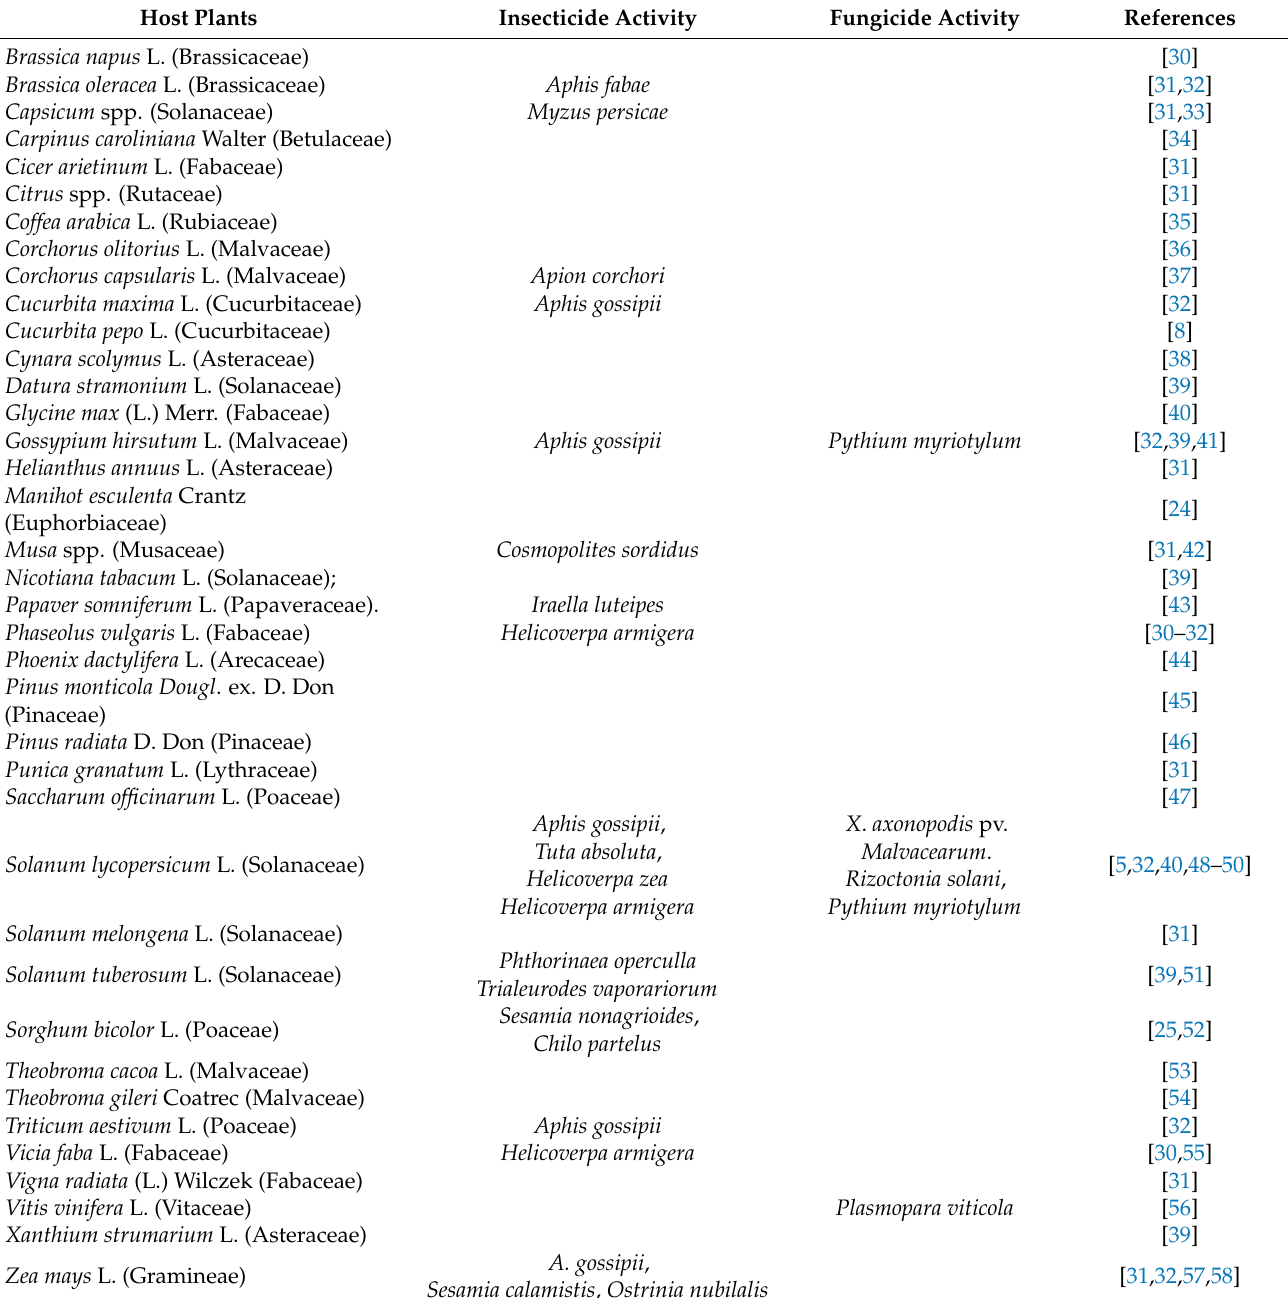
Table 1. List of host plants in which B. bassiana has been reported as an endophyte which include insecticide and fungicide